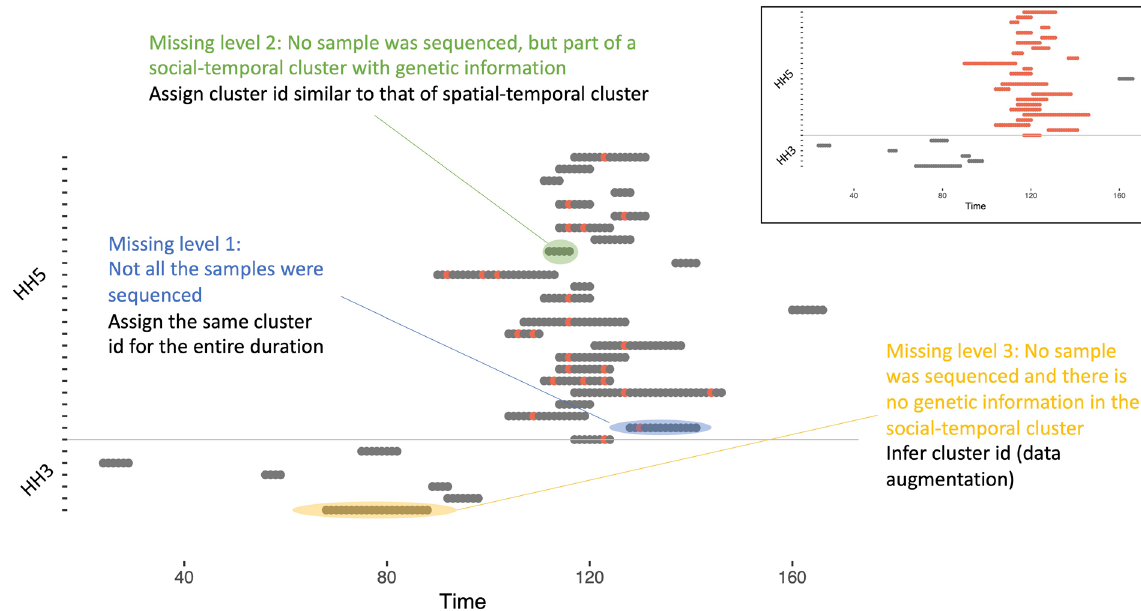
Figure 5. An illustration of the genetic cluster imputation process. Each notch on the y-axis represents a single individual in a household and the horizontal grey line separates the data from two households. Time in days is shown on the x-axis. Each shaded horizontal region shows an imputed shedding episode with the coloured dots showing the days in the episode where there is genetic cluster information. Inset: the results of imputing genetic information at missing level 1 and 2. This figure was partly generated using